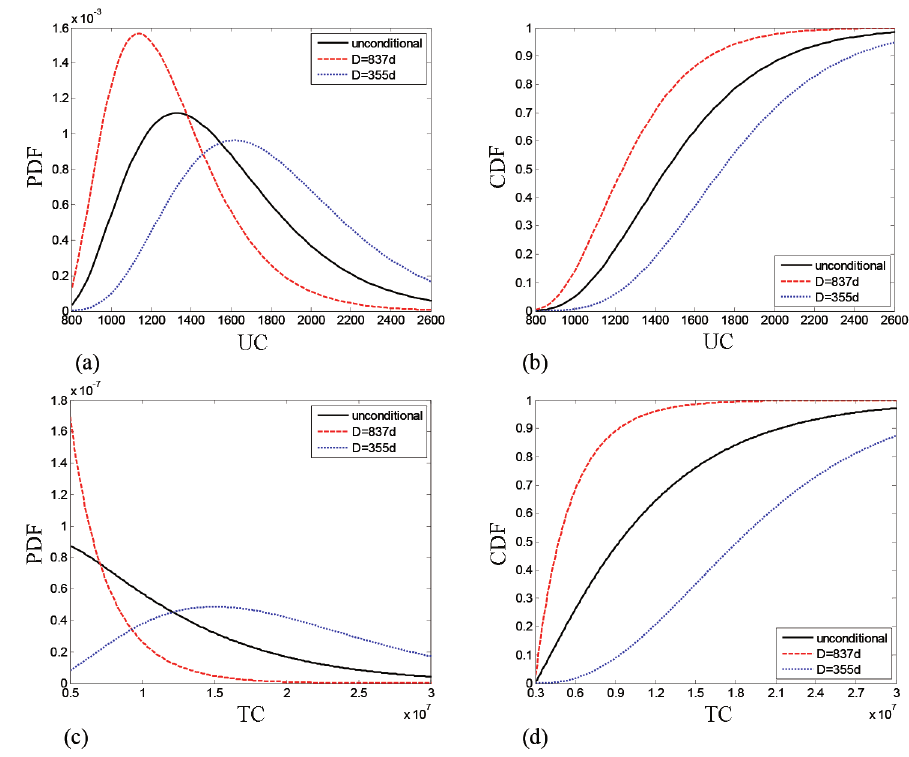
Figure 6. The conditional distribution of TC and UC given the value of